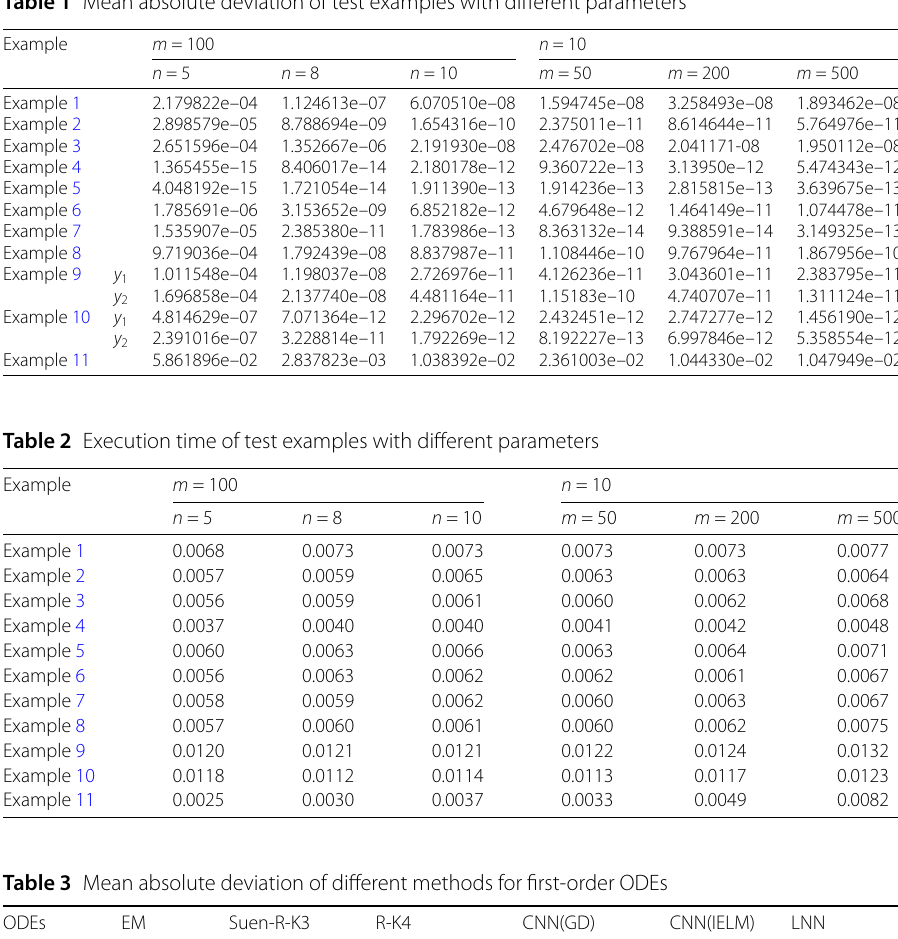
Table 1 Mean absolute deviation of test examples with different parameters